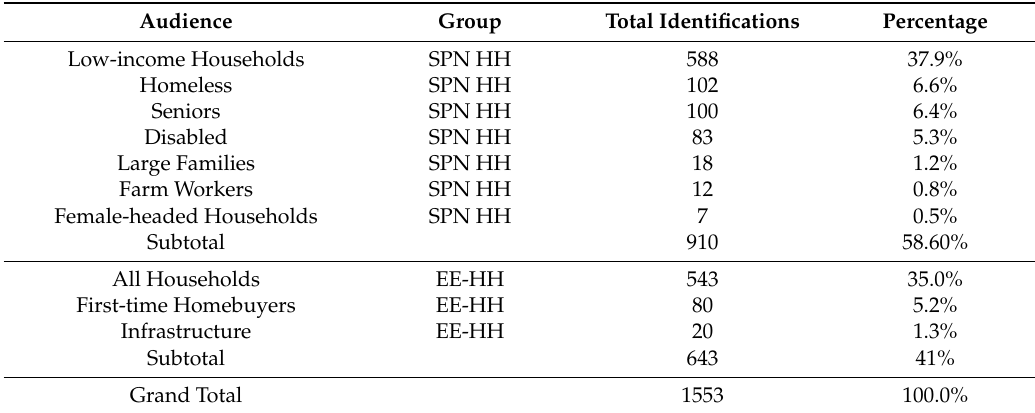
Table 3. Audience types by overall